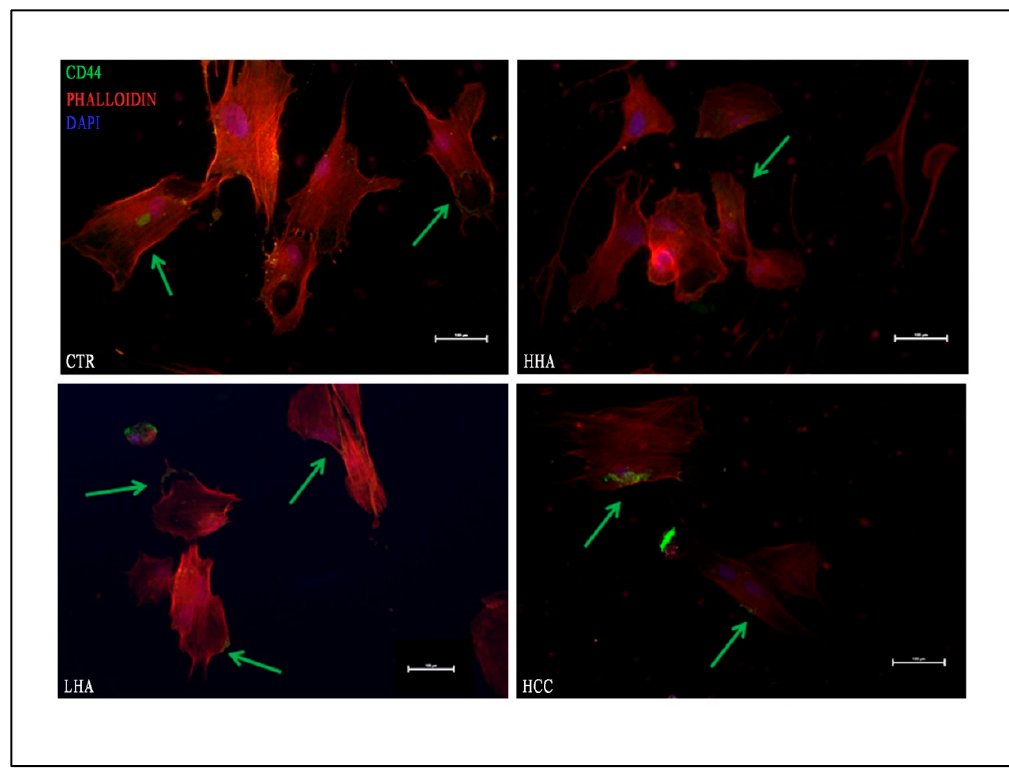
Figure 3. Evaluation of CD44 expression in hDPSCs after hyaluronans treatment in standard medium. CD44 marker was mainly localized on the hDPSCs cell surface with more areas of positivity after HCC treatment. CD44 in green, phalloidin in red; nuclei in blue. Green arrow indicates CD44 positivity. Scale bar: 100 μ m.